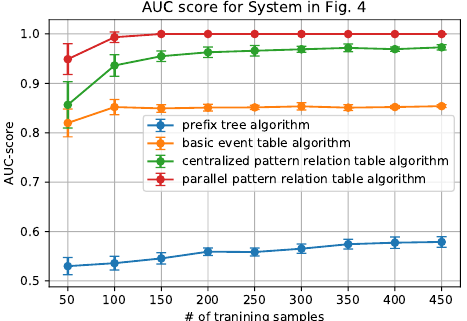
Figure 6. AUC score for System in Figure 4.